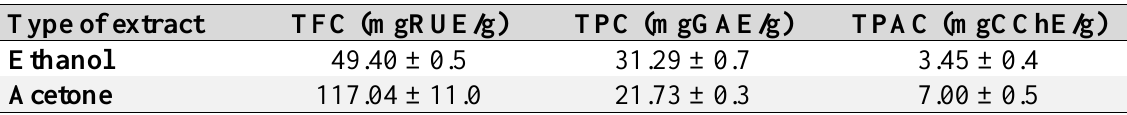
Table 6. Total phenolic (TPC), total flavonoid